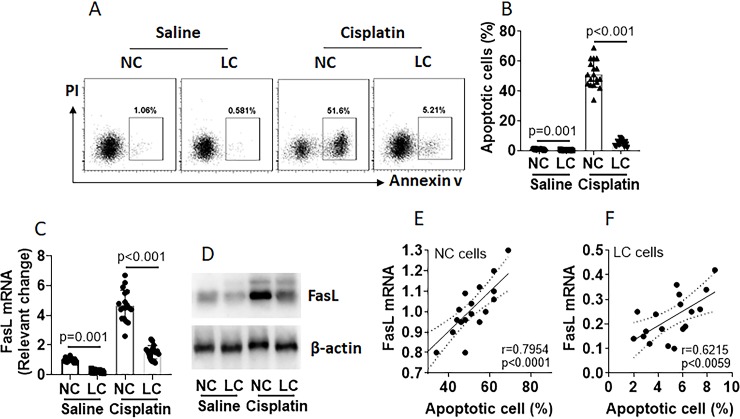
Apoptotic defects in LC cells.The lung cancer (LC) tissues were collected from LC patients (n = 18). LC cells and NC cells (marginal normal tissues; proved by a pathologist) were isolated from the tissues and exposed to cisplatin or saline (vehicle, used as a control) in the culture for 48 h to induce apoptosis. The cells were analyzed by flow cytometry, RT-qPCR and Western blotting. A, gated cells are apoptotic cells. B, summarized data of apoptotic cells in panel A. C, FasL mRNA levels. D, FasL protein levels. E-F, positive correlation between FasL mRNA and apoptotic cells after exposing to cisplatin. Data of bars are presented as mean ± SEM. Each dot in bars presents data obtained from one sample. Statistics: t test.